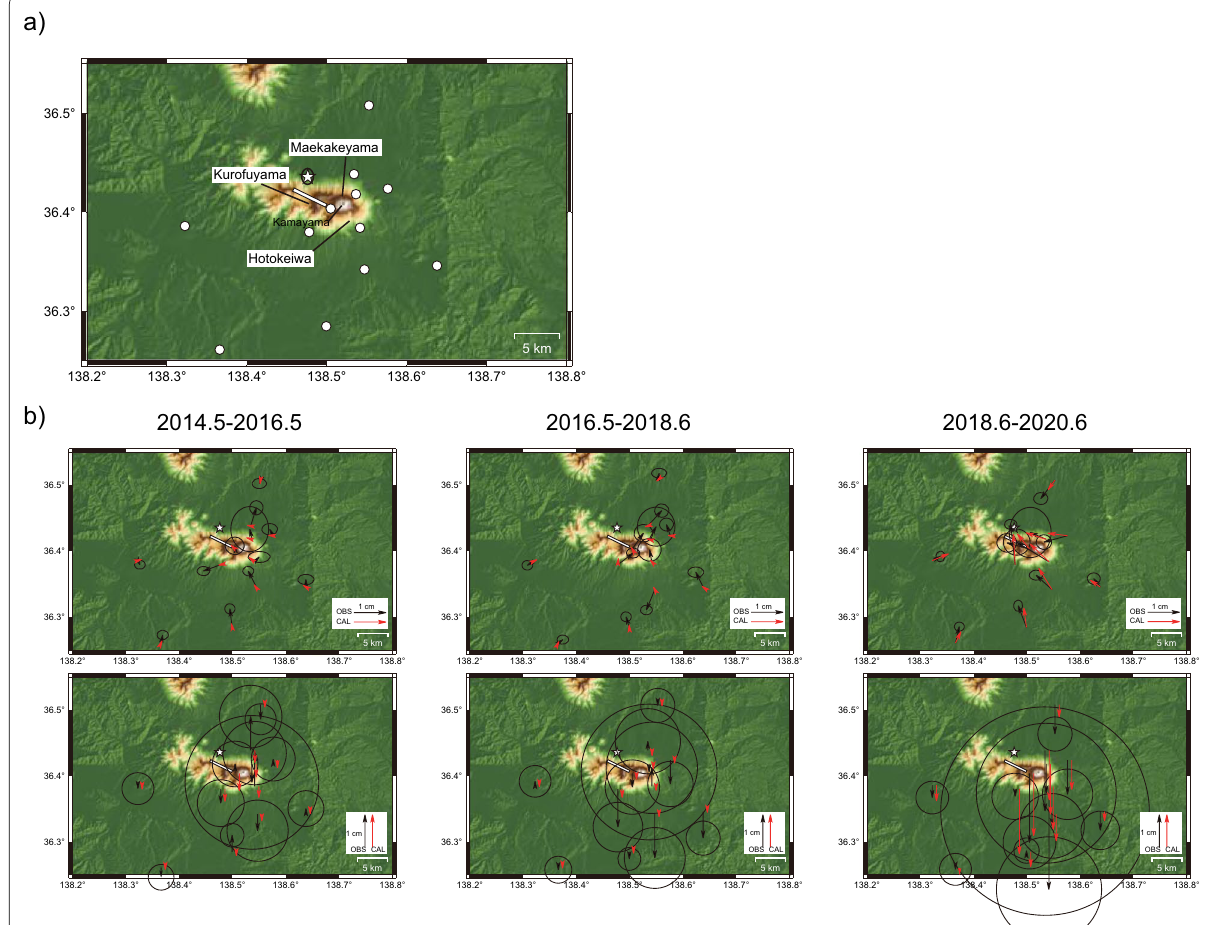
Fig. 5 Location of the estimated source, and observed and calculated deformation at sites around Asama volcano. a Location of the estimated source. Legends are the same as Fig. 4a. b Observed and calculated deformation. Legends are the same as Fig.